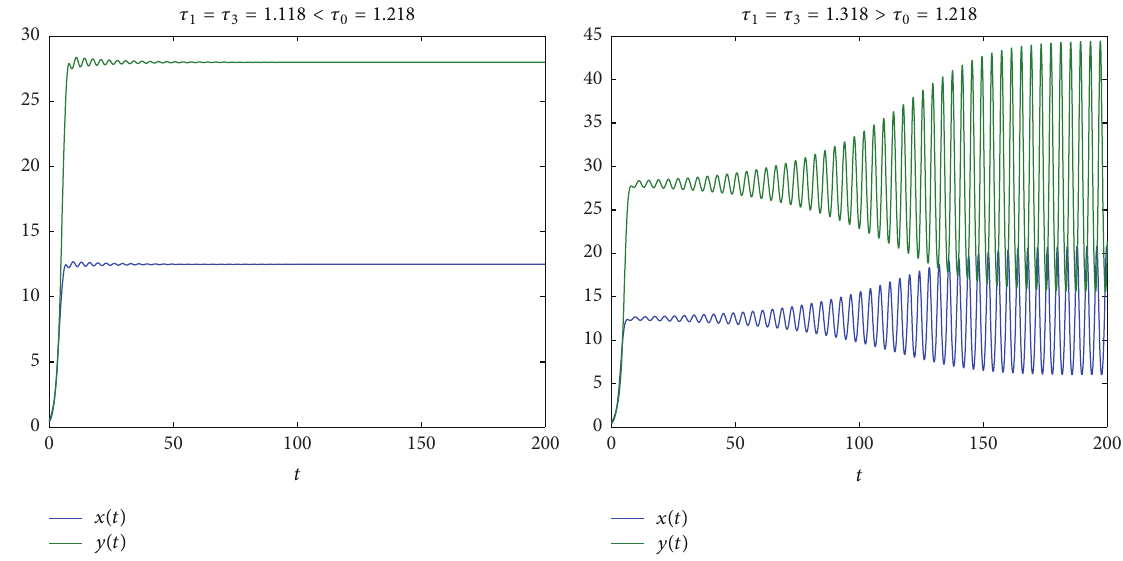
Figure 6: System (115) at 𝐸 ∗ undergoes a Hopf bifurcation for 𝜏 1 = 𝜏 3 > 𝜏 0 = 1.218 with initial value “0.4,